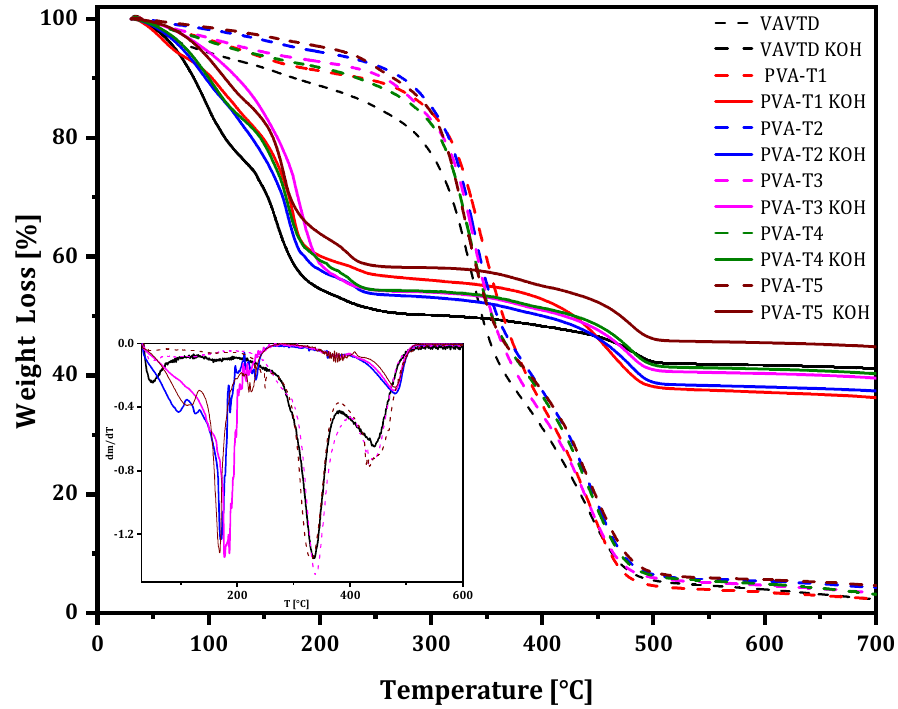
Figure 6. TG curves of PVA-VAVTD and PVA-VAVTD KOH membranes. Ins: DTG curves of electrolytes.